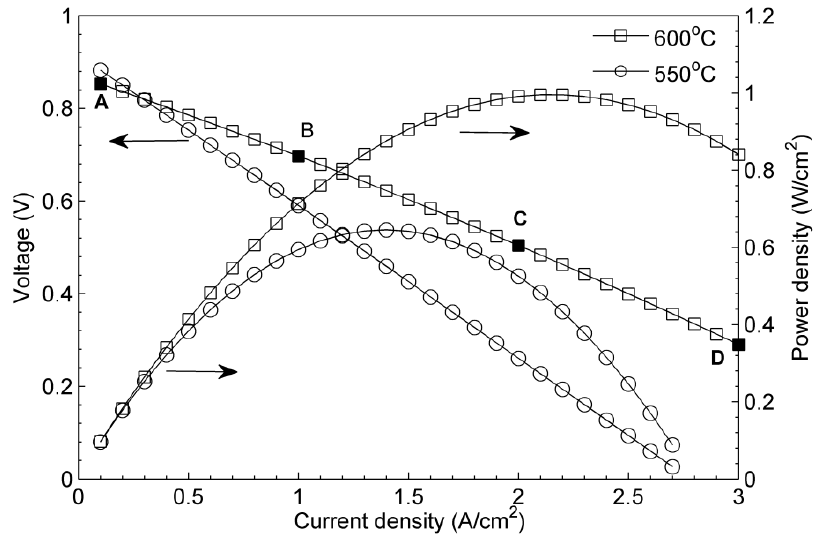
Figure 2. Experimental results of an IT-SOFC performance. Cell voltage and power density as function of current density at 600 and 550 °C